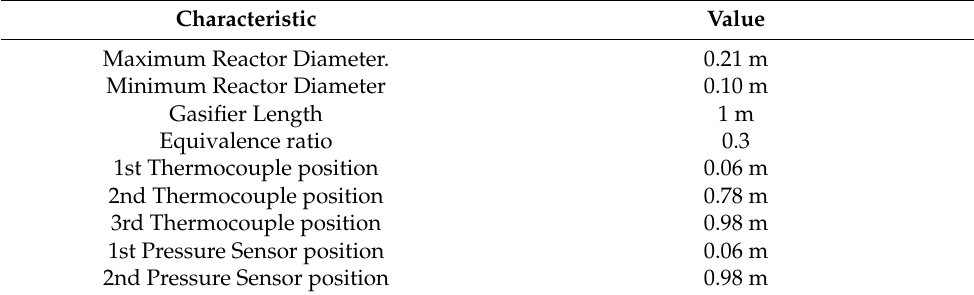
Table 5. Real gasifier characteristics.